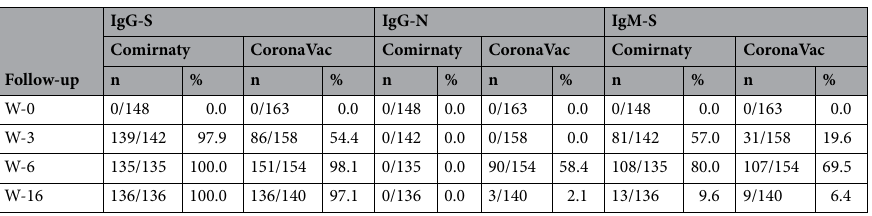
Table 2. Qualitative antibody responses to the Comirnaty and CoronaVac recipients. *Seropositivity thresholds: IgG-S (≥ 50 AU/mL), IgG-N (≥ 1.4 S/C), and IgM-S (≥ 1.0 S/C) are used. W-0, Week zero; W-3, Week three; W-6, Week six; W-16, Week 16.